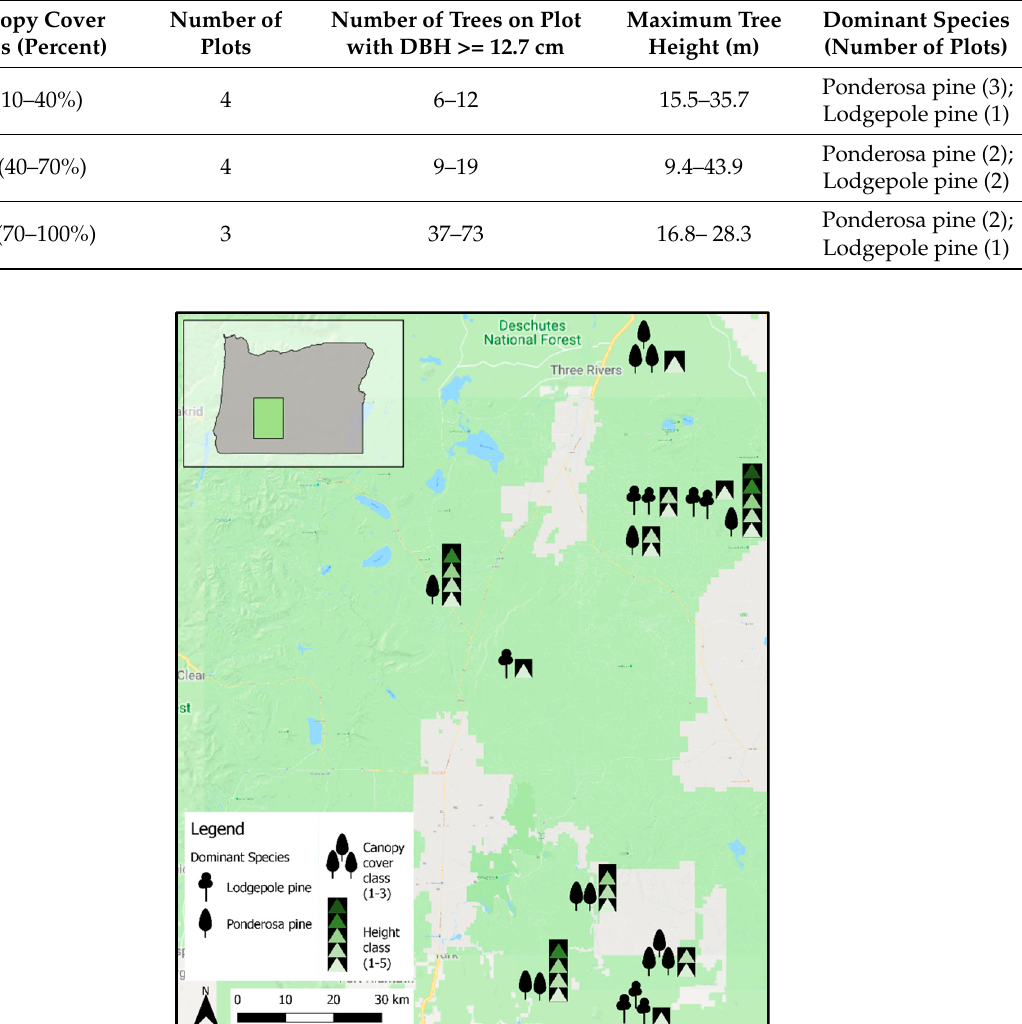
Table 2. Characteristics of sampled field plots.